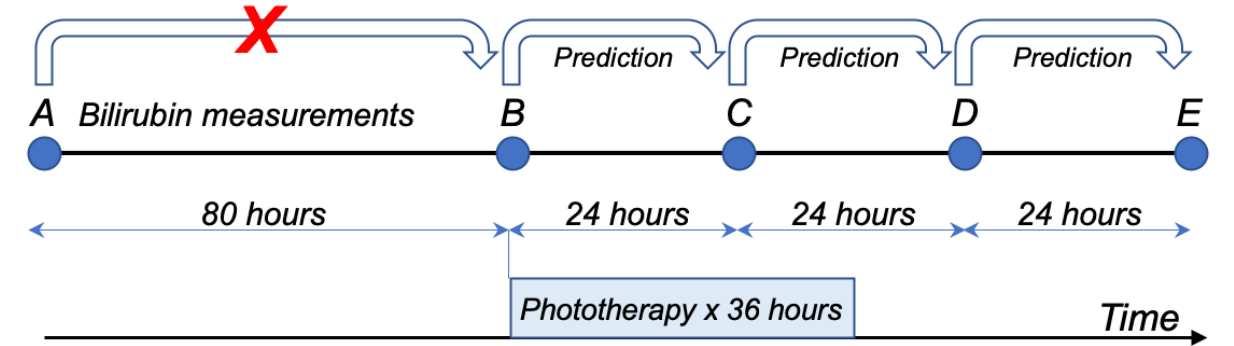
Figure 1. Schematic of a data inclusion mechanism for a hypothetical individual with 5 bilirubin measurements, A through E. The blue box represents the time period under phototherapy. Model training used features at the time of a bilirubin measurement to predict the value of a subsequent measurement ≤ 72 hours later. The predictive feature of fraction of time under phototherapy was 100% between B and C, 50% between C and D, and 0% between D and E. Data from bilirubin measurement A to predict B were not included for model training because the subsequent measurement was ≥ 72 hours